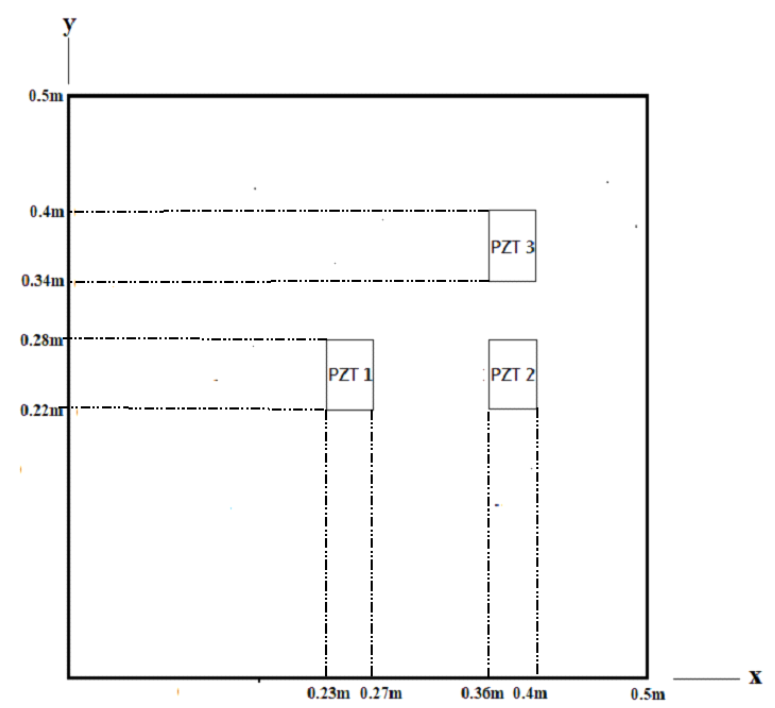
Figure 7. Three different locations of the surface-bonded PZT actuators.